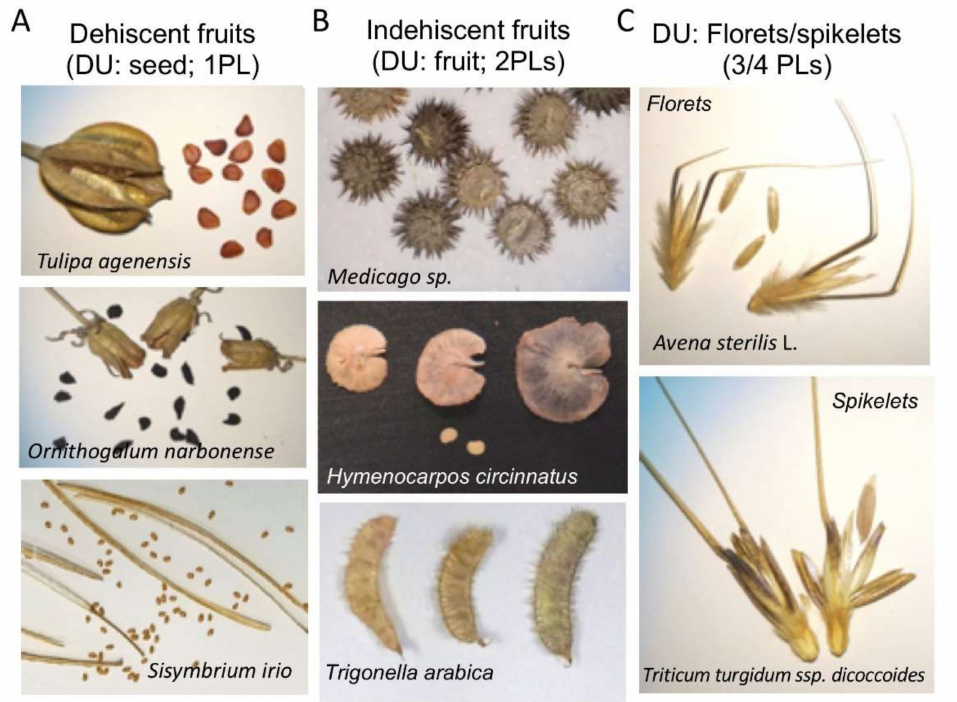
Figure 1. Examples of various dispersal units (DUs) in angiosperms. ( A ) Dehiscent fruits, the seed represents the DU and embryo in covered by a single protective layer (1PL). ( B ) Indehiscent fruits, which constitute the DUs and the embryo is covered by 2PLs. ( C ) Common DUs in grasses whereby the floral bracts (glumes, lemmas, paleae) enclose the caryopsis (a one seeded fruit), to form two types of DUs, florets and spikelets, and thus the embryo is covered by three and four PLs,